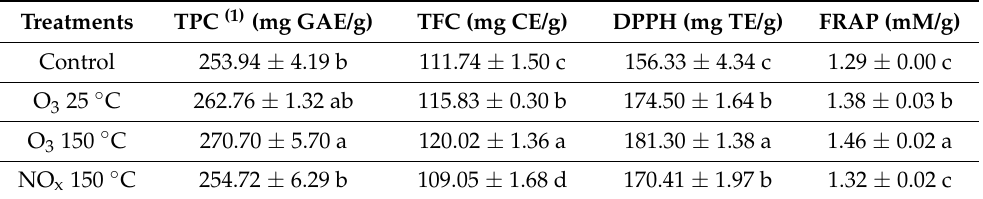
Table 2. Content of functional compounds and antioxidant activities of components in atmospheric- pressure plasma-treated peanut